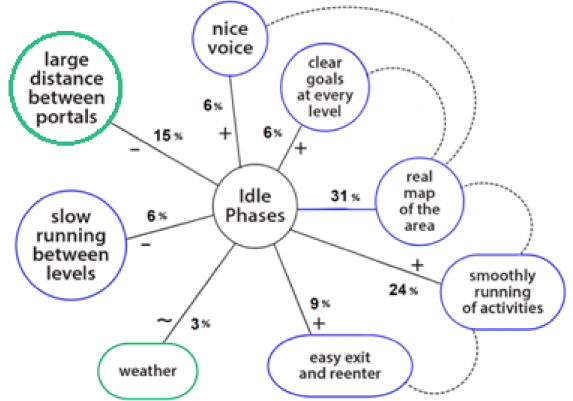
Figure 4. Subthemes (with percentages of mentions) related to the main thematic “idle phases”, as derived from the content analysis of the responses to question 4. The subthemes “clear goals at every level”, “real map of the area”, “smoothly running of activities”, “easy exit and reenter”, and “weather” were mentioned more than once by the participants, who also mentioned the subthemes that are connected with dotted links. Subthemes in blue relate to the game, and those in green relate to the environment. The signs +, − , and ~ represent the learners’ disposition towards the subtheme to which these signs relate (positive, negative, and neutral disposition,